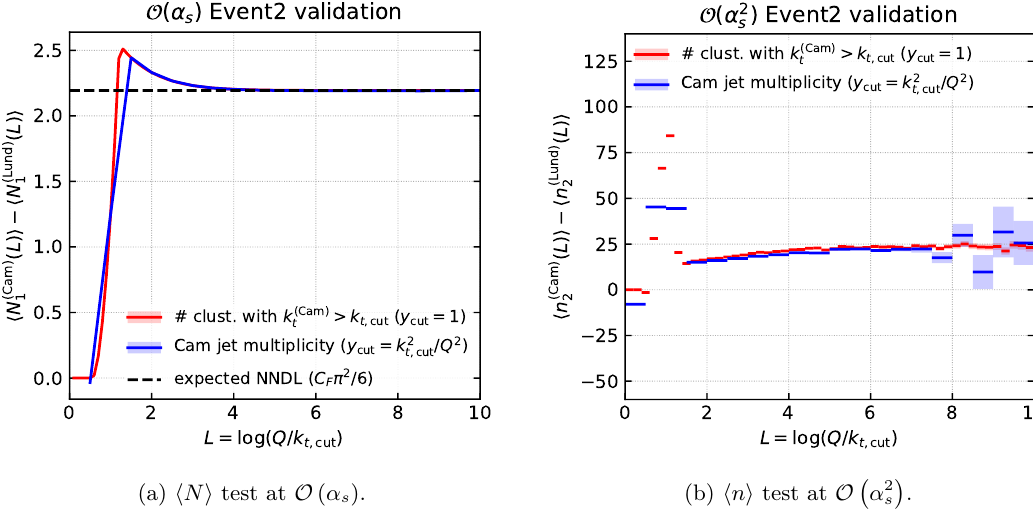
Figure 11. Comparison between the Lund and Cambridge multiplicities at fixed-order with the Event2 program: (a) the (cumulative) multiplicity difference h N (Cam) compared to the NNDL analytic expectation (b) the differential multiplicity difference h n (Cam) h n (Lund)